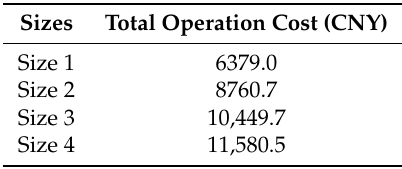
Figure 28. The iterative process comparison of the operation cost in Period 23 between three MGs of different sizes. Table 10. Total operation cost comparison between 3 MGs of different